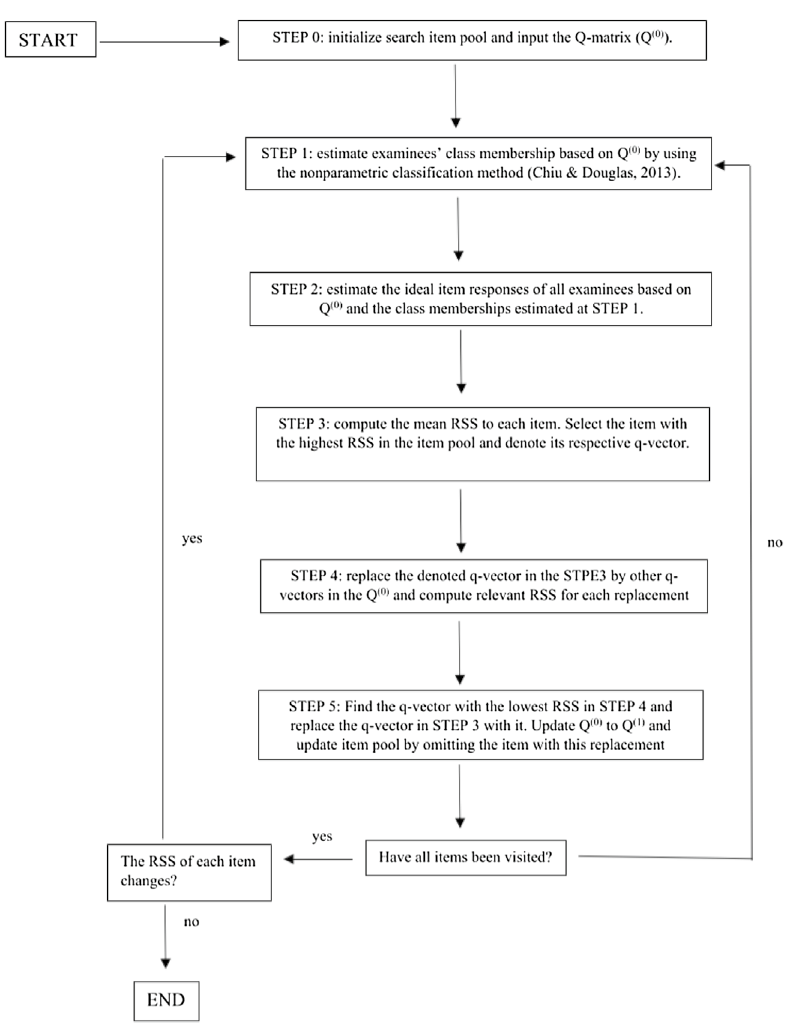
Note . This flowchart was created based on the explanations of “Statistical refinement of the Q-matrix in cognitive diagnosis.” by Chiu, C. Y., 2013, Applied Psychological Measurement, 37(8), 598-618. Fig. 4 Flowchart of Chiu’s method . This flowchart was created based on the explanations of Chiu